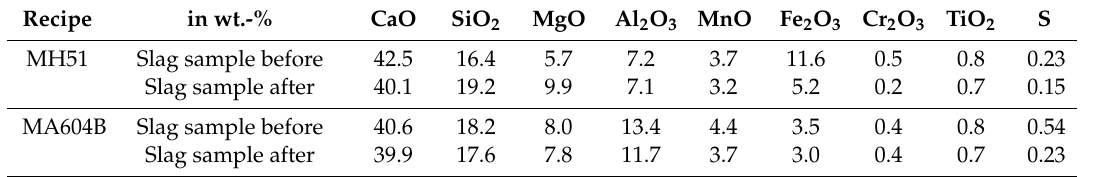
Table 7. Composition of the slag before and after adding the